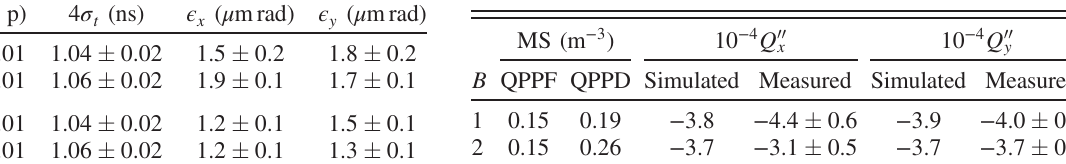
TABLE VI. Q 00 MAD - X calculations vs measurements for the two LHC beams ( B ) with powering of the main sextupoles (MS) at zero Landau octupole current after the Q 00 adjustment pro- cedure targeting an amount of Q 00 x;y ¼ − 4 × 10 4 units in both